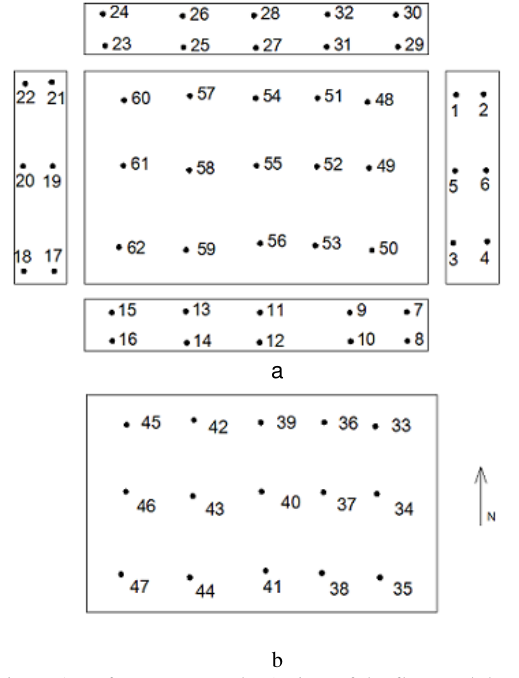
Figure 1. Reference network: a) view of the floor and the walls projected on each side; b) view of the